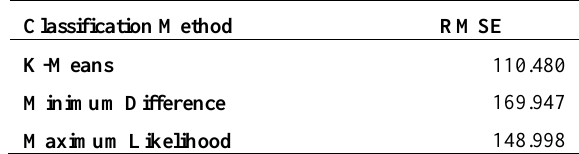
Table 10: The RMSE values calculated for the comparison of Worldview and Landsat